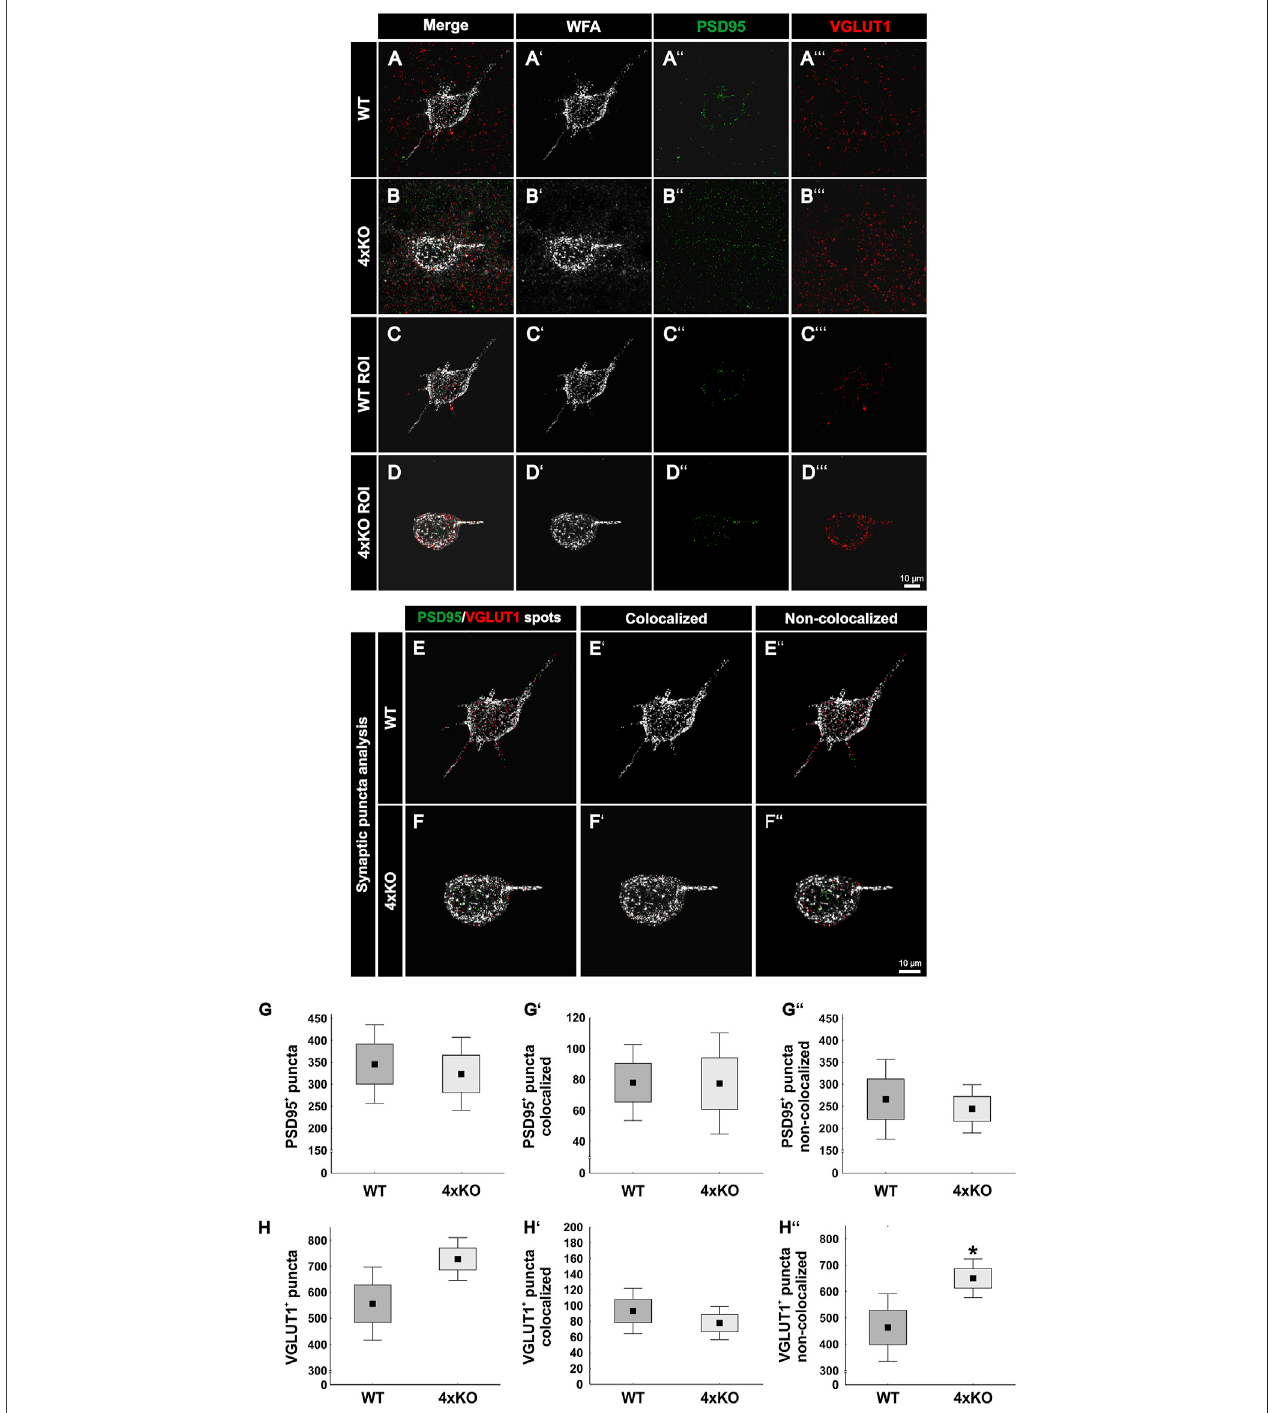
FIGURE4| ExpressionofPSD95-positiveand VGLUT1-positivesynaptic puncta at wildtype and quadrupleknockout PNNs intheV1. (A and B ’’’ ) Representative SIM image representing immunohistochemical stainings of WFA-positive PNNs (white) and excitatory synapses with PSD95 as a marker for excitatory postsynapses (green)andVGLUT1asamarkerforexcitatorypresynapses(red). (C and D ’’’ ) AnROIwasgenerated,includingsinglewildtypeandquadrupleknockoutPNNswiththeir perforatingexcitatorysynapses. (E and F ’’ ) Forquantitativeevaluation,colocalizedPSD95spotsarerepresentedinlightgreen,VGLUT1spotsinlightred,andnon- colocalized spots in dark green or rather dark red. (G – G ’’ ) The total number of PSD95-positive synaptic puncta, the number of PSD95-positive and VGLUT1-positive colocalized synaptic puncta, and the number of non-colocalized PSD95-positive synaptic puncta along the PNNs were quanti fi ed. No difference in the total number of PSD95-positive synaptic puncta ( p = 0.72) nor in the number of colocalized ( p = 0.98) or non-colocalized PSD95-positive synaptic puncta ( p = 0.69) between wildtype